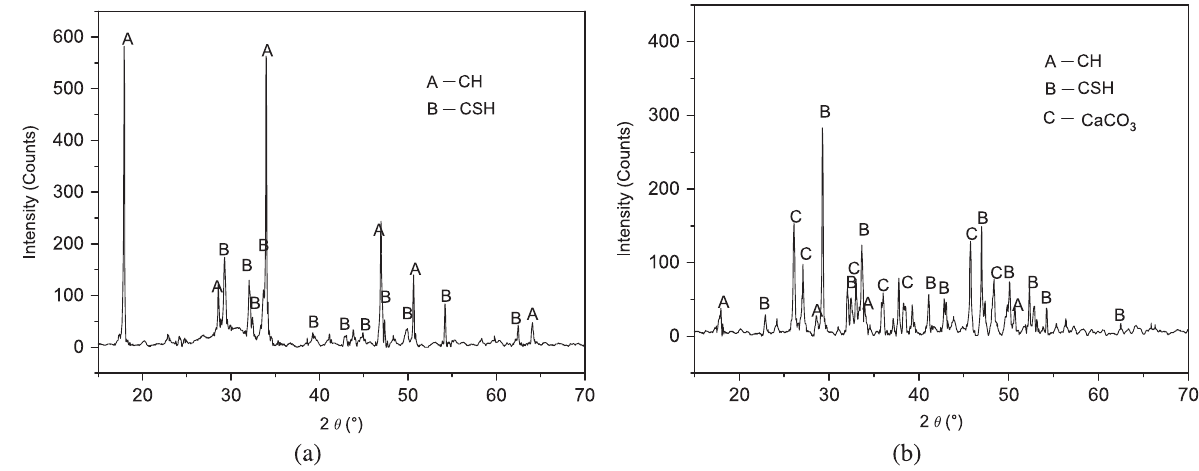
Figure 4: XRD of cement near the interface. (a) 20th day and (b) 40th